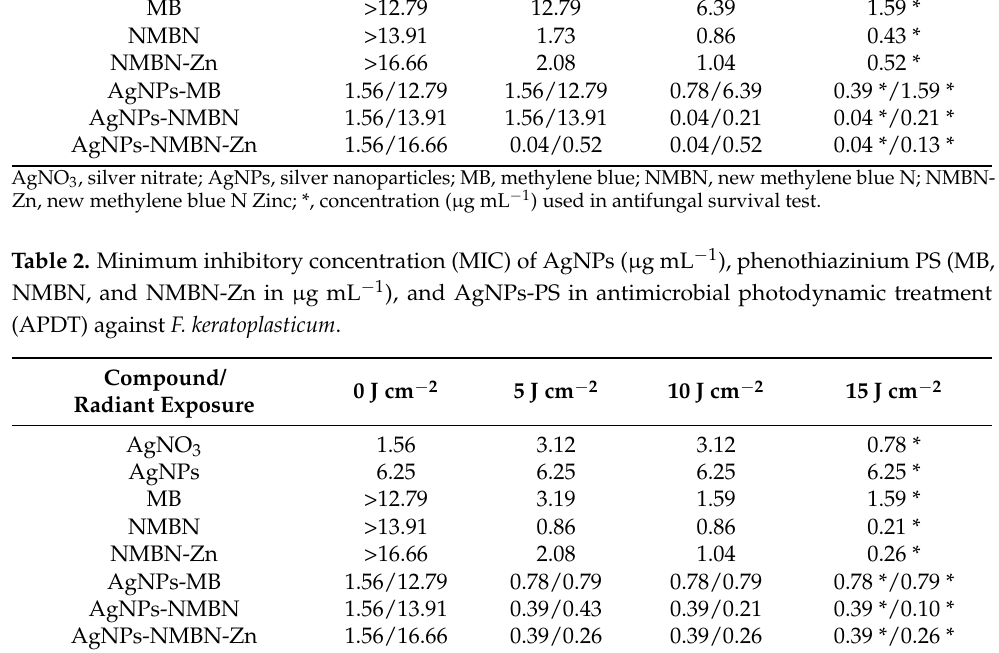
AgNO 3 , silver nitrate; AgNPs, silver nanoparticles; MB, methylene blue; NMBN, new methylene blue N; NMBN- Zn, new methylene blue N Zinc; *, concentration ( µ g mL − 1 ) used in antifungal survival test.